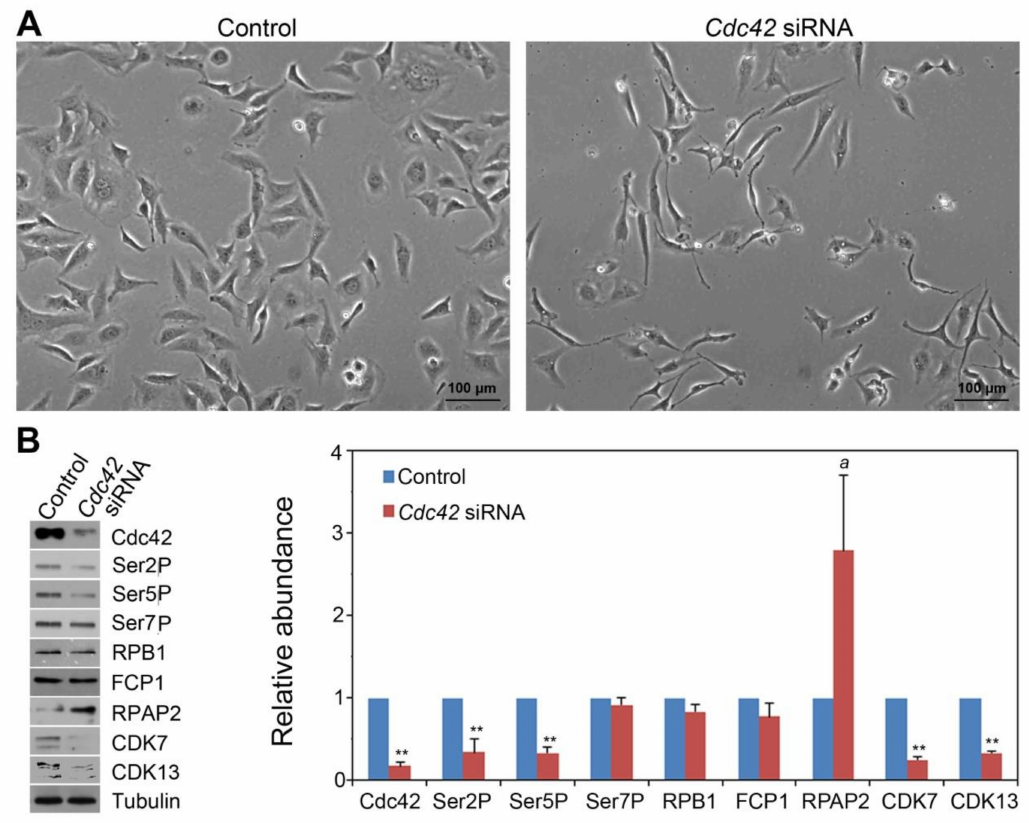
Figure 2. siRNA-based Cdc42 knockdown modulated the CTD phosphorylation code and a ff ected the level of CTD phosphatases and kinases in HeLa cells. ( A ) HeLa cells 48 hr after Cdc42 siRNA transfection. ( B ) Western blot showing the levels of Cdc42, Ser2P, Ser5P, Ser7P and CTD phosphatases (FCP1 and RPAP2) and kinases (CDK7 and CDK13) in Cdc42 siRNA-transfected HeLa cells. Tubulin was used as the protein loading control. Quantitative analysis of the Western blot results from two independent biological replicates was shown. Protein level in the control was set as 1.0. Significance level is indicated by * ( p < 0.05) or ** ( p < 0.01) vs. control. The letter a above the column indicates a marginal di ff erence ( p = 0.058) compared to